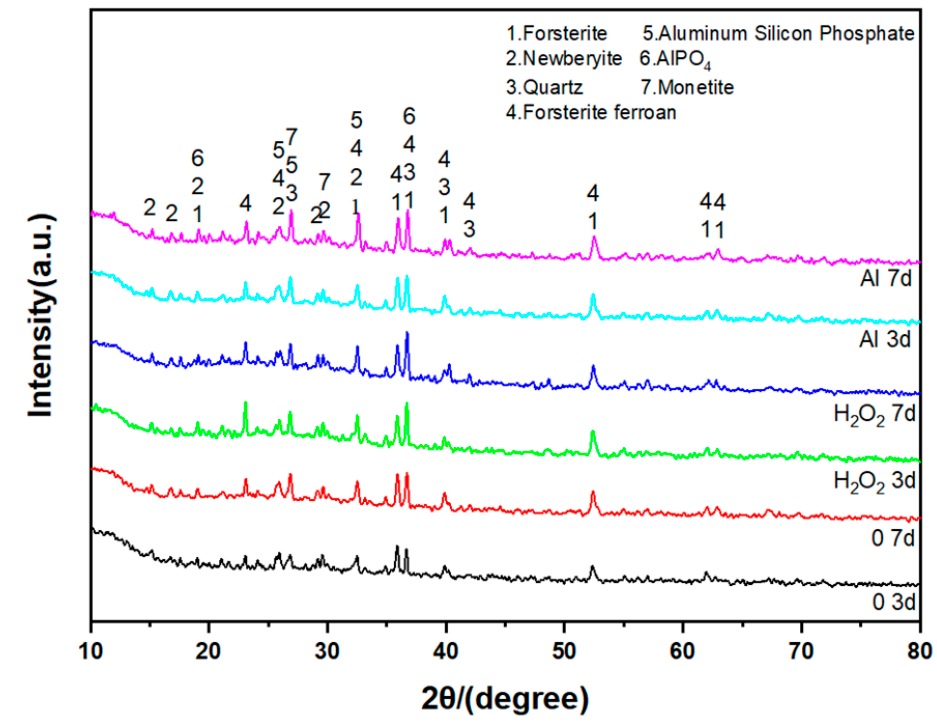
Figure 12. XRD patterns of the specimens prepared without a blowing agent and those prepared with different blowing agents.